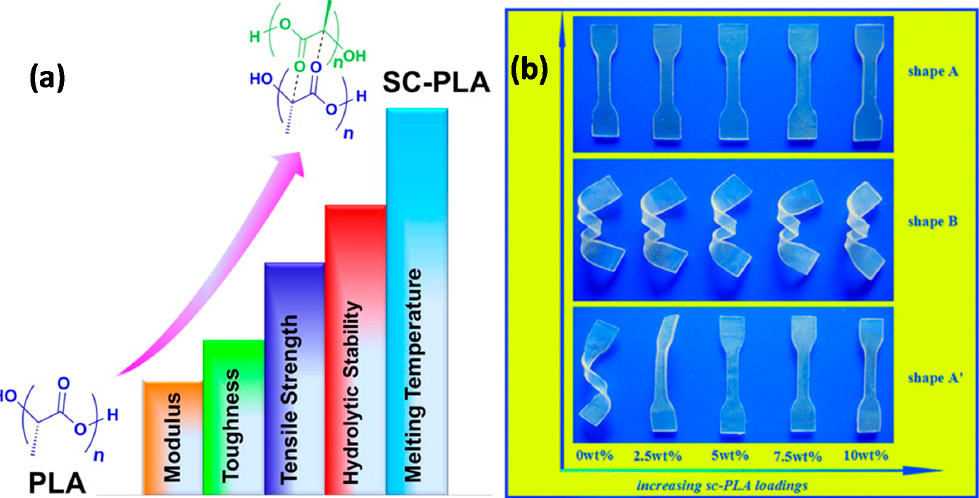
Figure 3. ( a ) Schematic representation of thermal and mechanical enhancement possibilities of PLA via stereo-complexation of PLA in different polymeric systems, including enantiomeric PLA homopolymers and PLA-based block and graft copolymers, as well as enantiomeric PLA materials; ( b ) Photographs of the shape recovery of neat PDLLA and the blend samples of PDLLA with increasing stereo-complex PLA loadings [52].